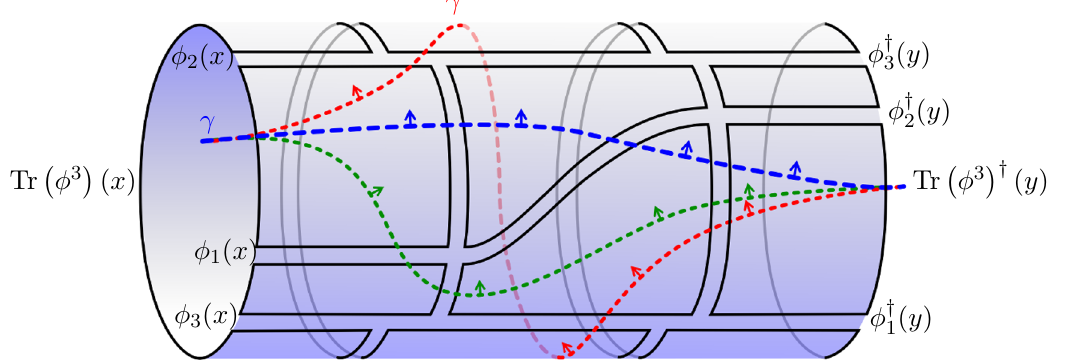
Figure 1 . A Feynman diagram that contributes to the two-point functions of twisted operators of length L = 3. The dashed lines indicate di(cid:11)erent possible choices for the cut used in the perturbative de(cid:12)nition. Every propagator crossing the cut is replaced by a twisted propagator as explained in the text. The red dashed line wraps around the cylinder once more than the blue one does, and correspondingly the result di(cid:11)ers by the action of the symmetry transformation, R , on the external operator Tr( (cid:30) 3 ) y ( y